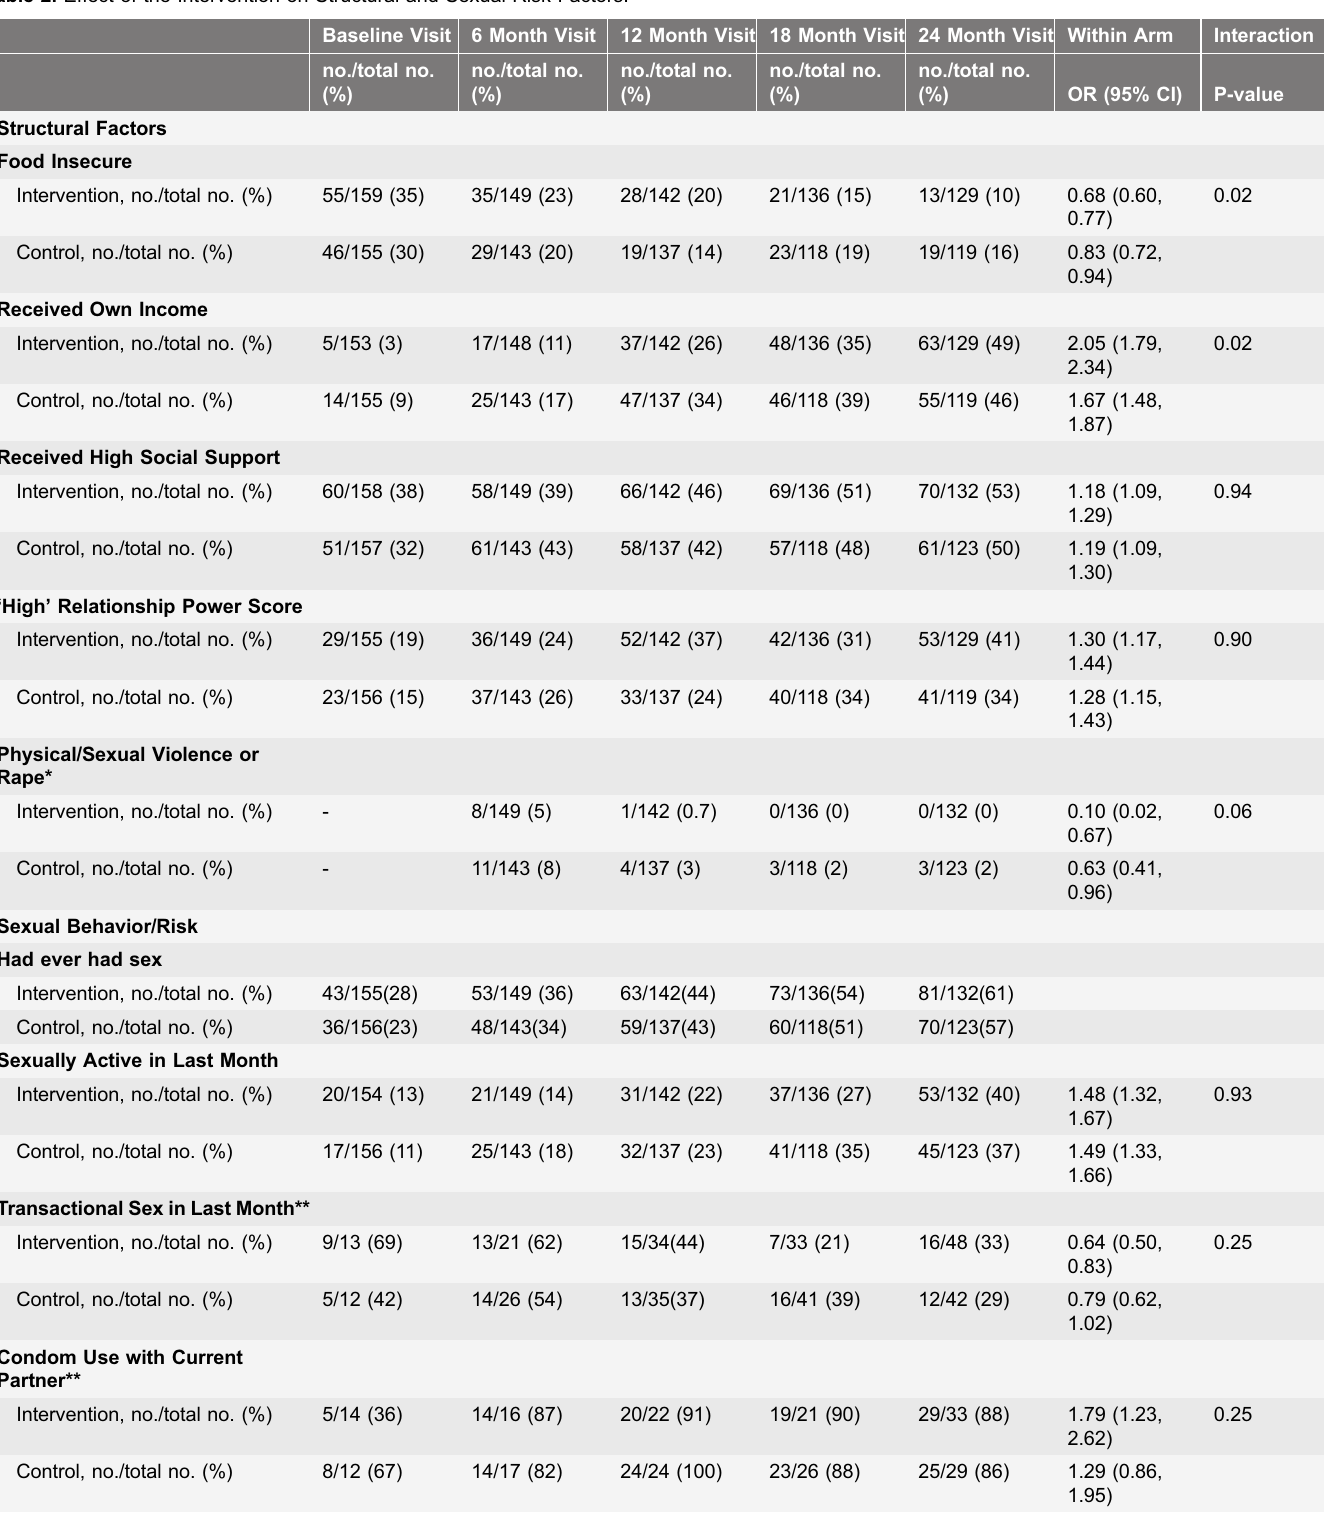
Table 2. Effect of the Intervention on Structural and Sexual Risk